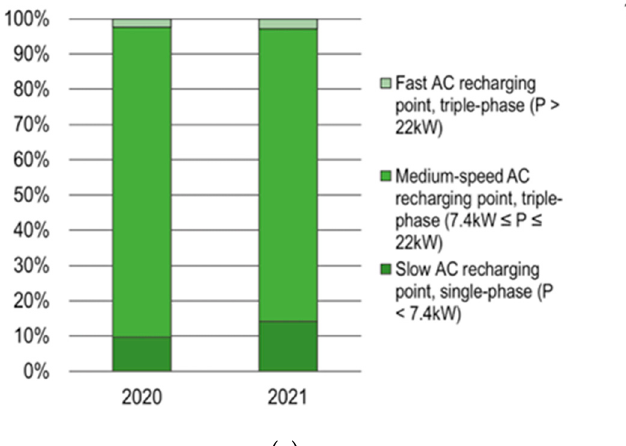
Figure 2. Public charging points by charging current.